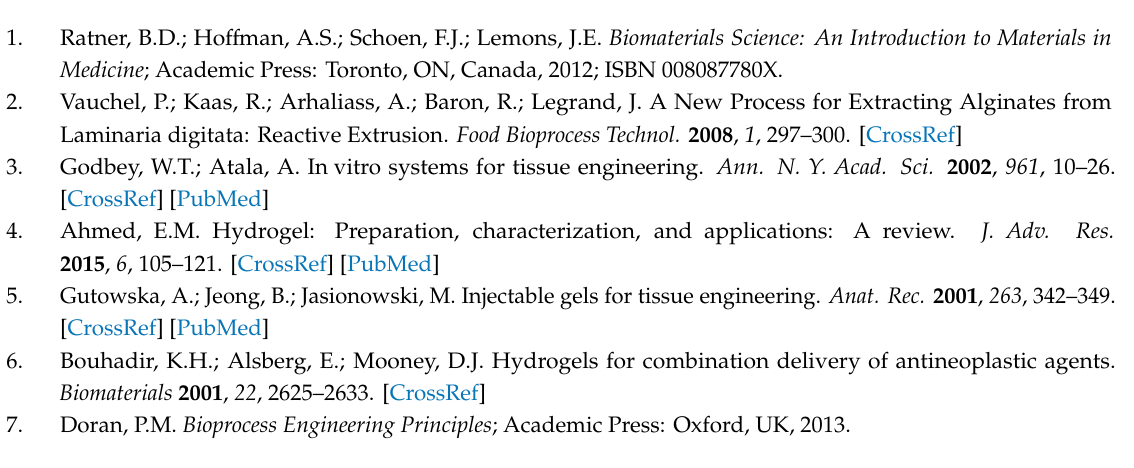
Figure S1: 1H-NMR spectrum of the partly hydrolyzed sodium alginate: anomeric area (a) and full 1H-NMR spectrum (b), Figure S2: Raman continuous scans of one-dimensional carbon nanofibers (a) and two-dimensional graphene oxide nanosheets